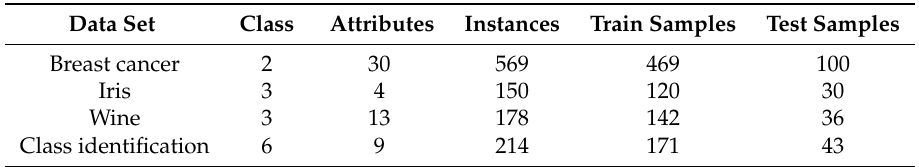
Table 4. Standard data sets information based